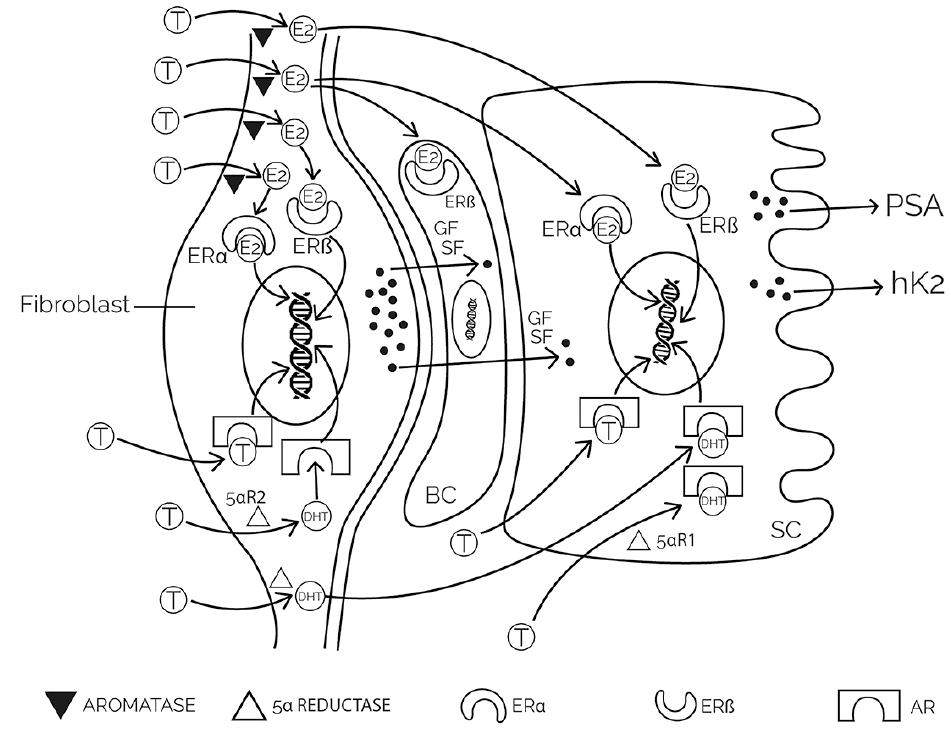
Figure 1. Stroma–epithelium interaction. E2 = estradiol; T = testosterone; 5 α -DHT = 5 α - dihydrotestosterone; GF = growth factor; SF = survival factor; PSA = prostate specific antigen; hK2 = human glandular kallikrein; BC = basal cell, SC = secretory cell. (Drawing: Pej č i ć T.).